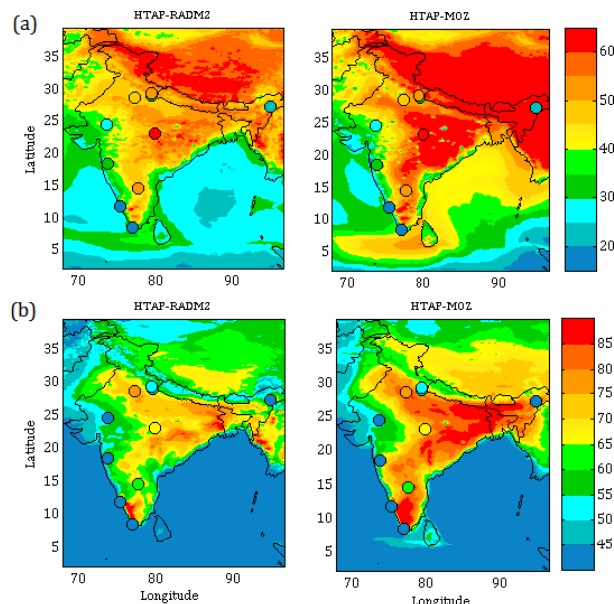
Figure 8. Monthly (April) average surface ozone calculated for (a) 24h and (b) noontime (11:30–16:30IST), comparing the chemical mechanisms (RADM2 and MOZART). The average ozone mixing ratios (ppbv) from observations are also shown for comparison on the same colour scale. Note the difference in colour scales in the top and bottom rows.